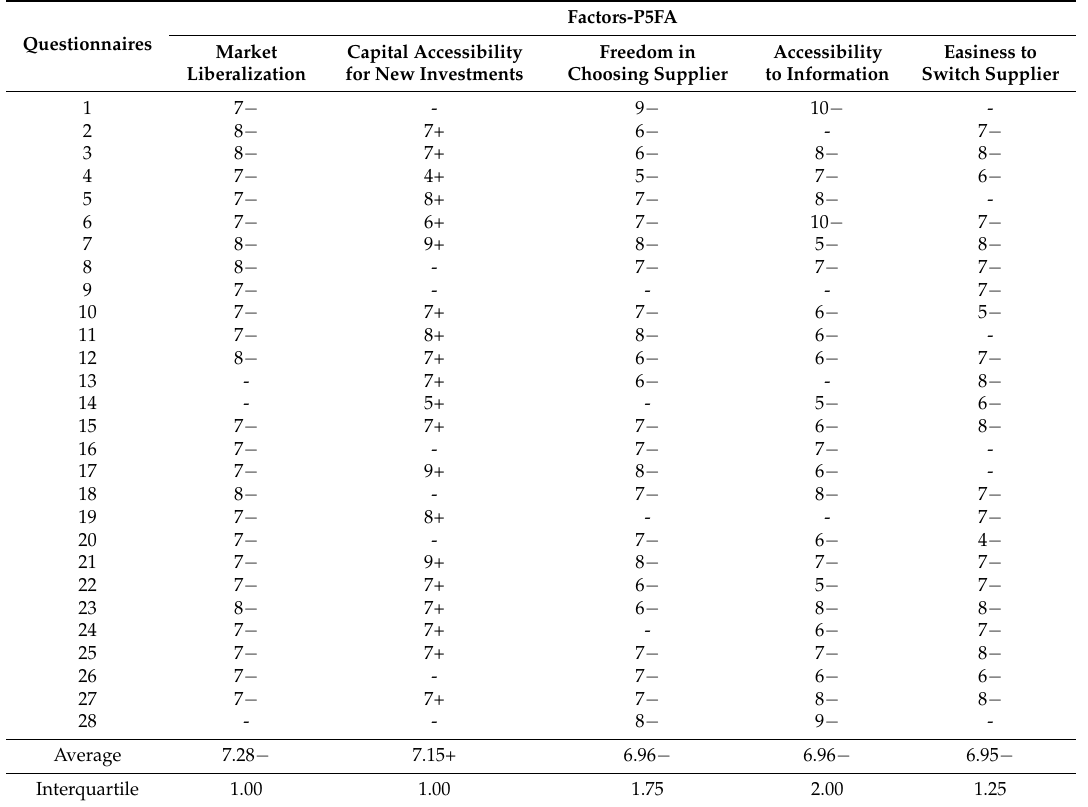
Table A3. Consistency check of the experts’ answers, Porters’ five forces analysis—interquartile range calculation (last line), empty cells (-) define no answers given.